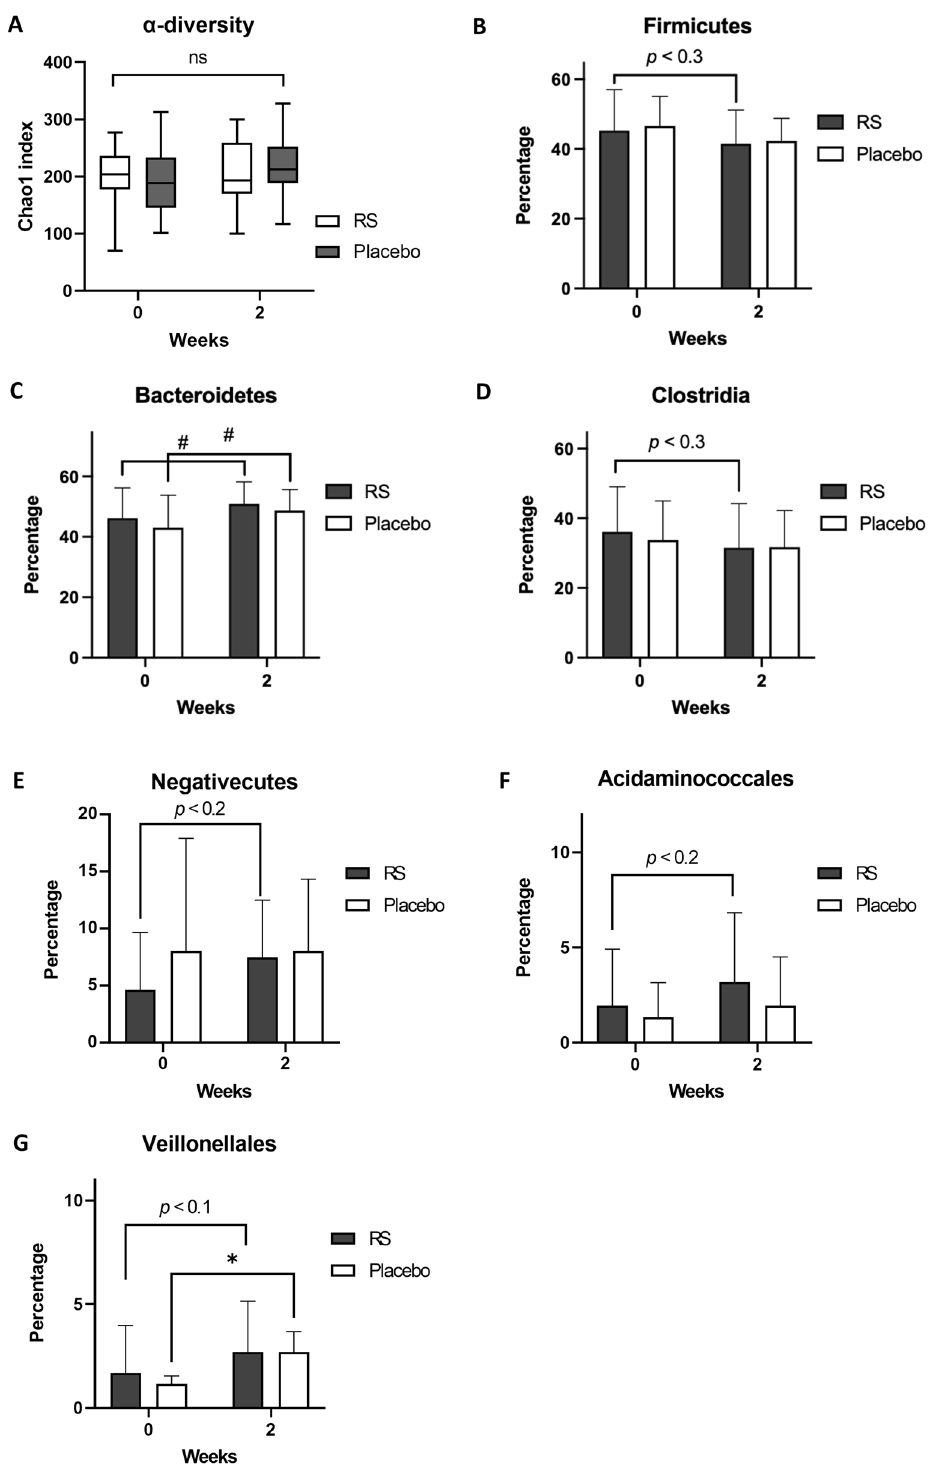
Figure 3. Difference in bacterial composition between RS and placebo group. ( A ) α-diversity analysis. ( B , C ) Firmicutes ( B ) and Bacteroidetes ( C ) alteration during the trial. ( D,E ) In Firmicutes phylum, Clostridia class showed a tendency ( p < 0.3) to decrease in RS group ( D ), whereas Negativicutes class increased ( p < 0.2) in RS ( E ). ( F,G ) In Negativicutes class, Acidaminococcales order increased in RS group ( F ), whereas Veilonellales increased in both groups ( G ). # p < 0.1, * p < 0.05. n = 19, error bars indicate